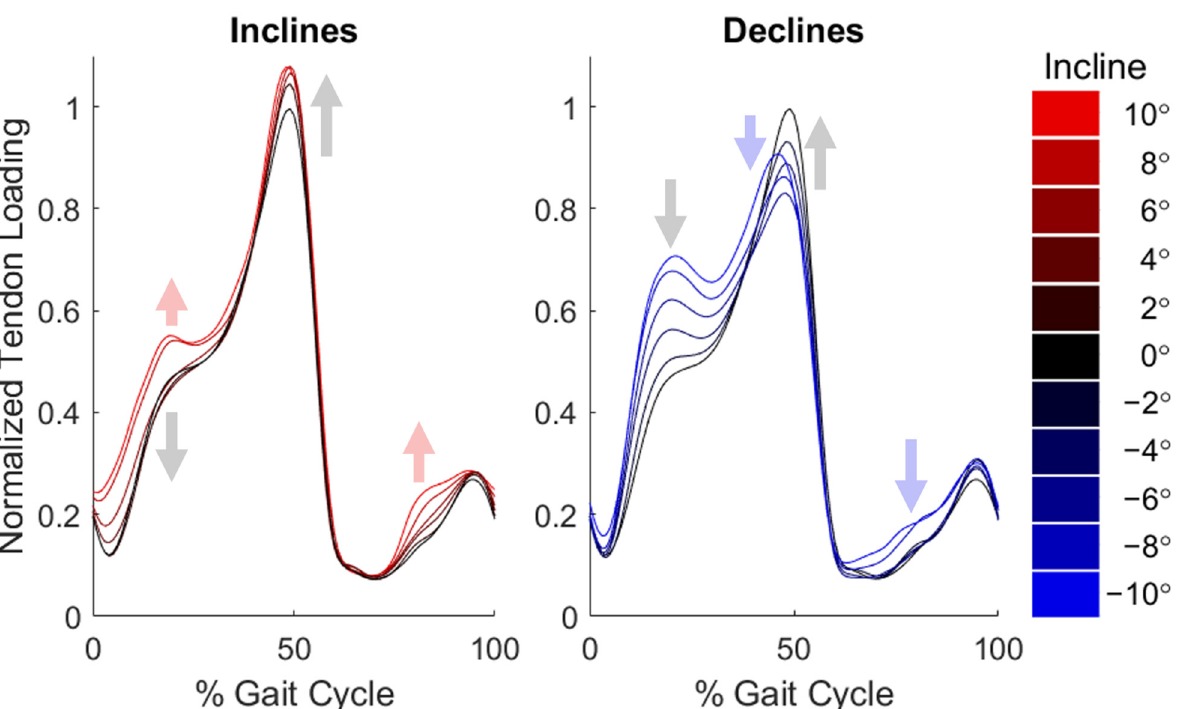
Figure 3. Mean normalized wave speed trajectories over the gait cycle in each slope bin across 11 participants. Gray arrows indicate trends with increasing slope across moderate slopes, while colored arrows indicate trends unique to steep slopes.